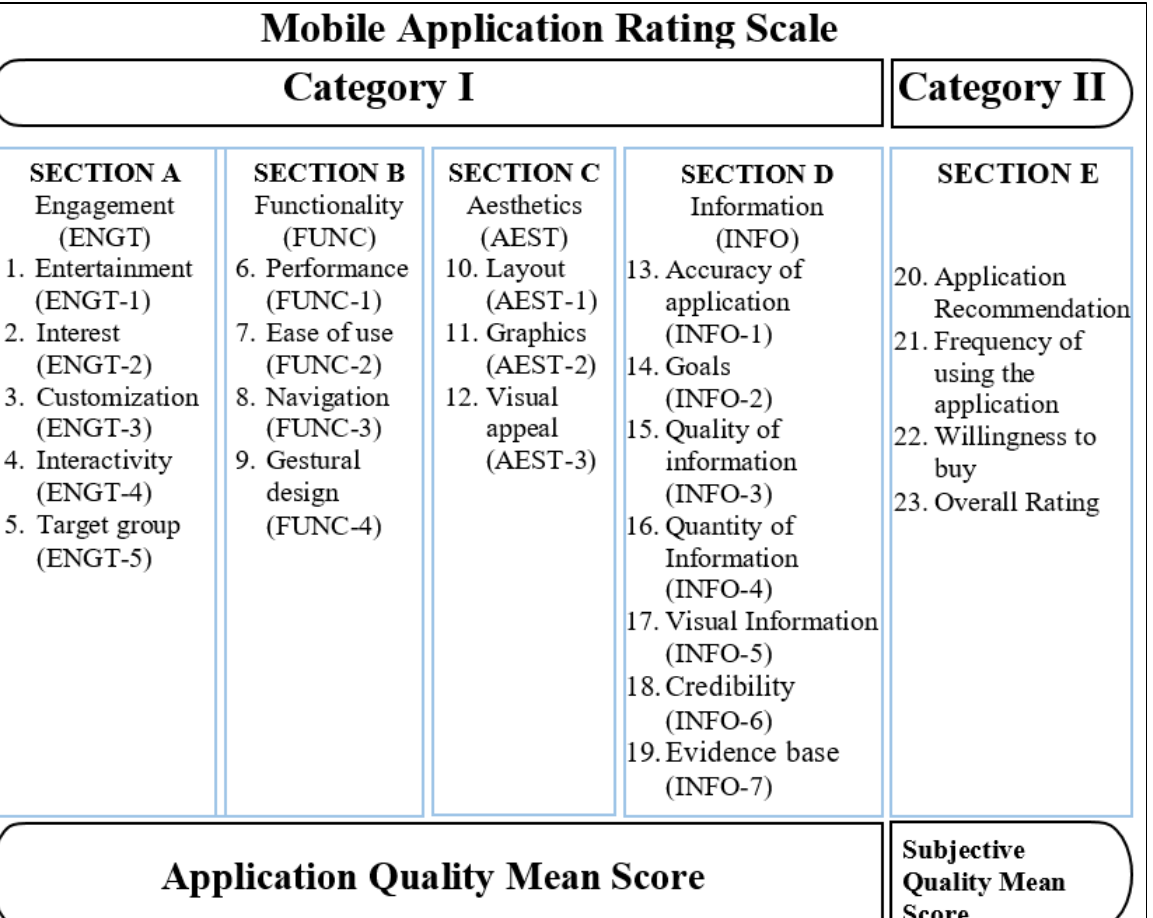
Figure 1. Categories of MARS.